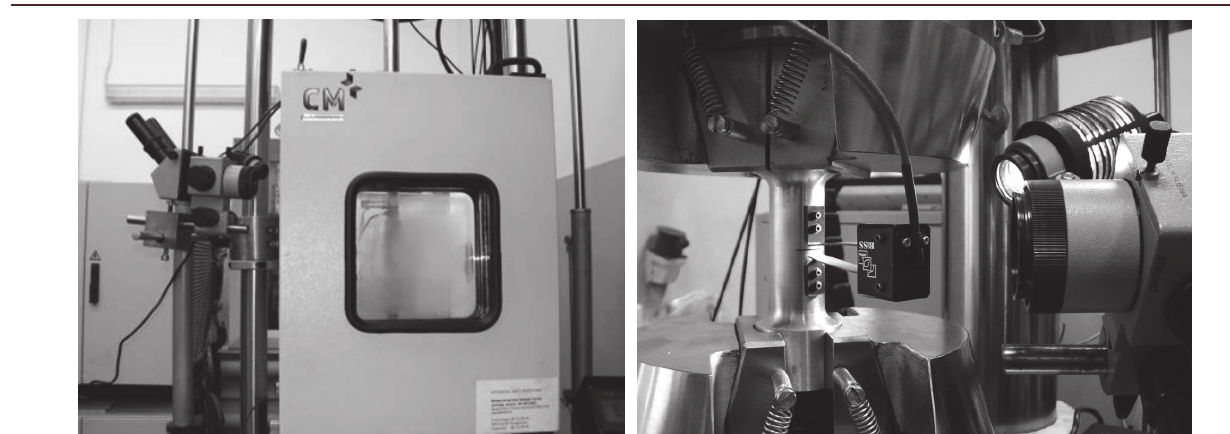
Figure 2: Low/high temperature test equipment.